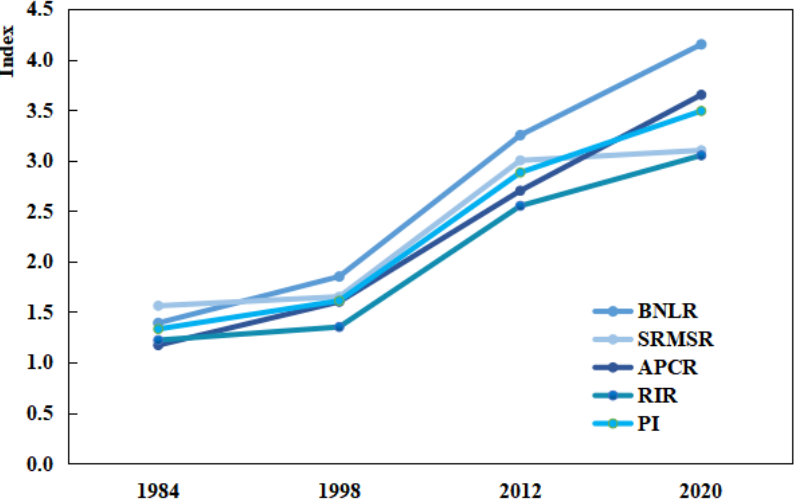
Figure 8. Intensity index of the place identity of local farmers. BNLR = The recognition of residents on beautiful natural landscape; SRMSR = The recognition of residents on standardized rural management system; APCR = The recognition of residents on agricultural productive conditions; RIR = The recognition of residents on rural infrastructure; PI = Place identity.